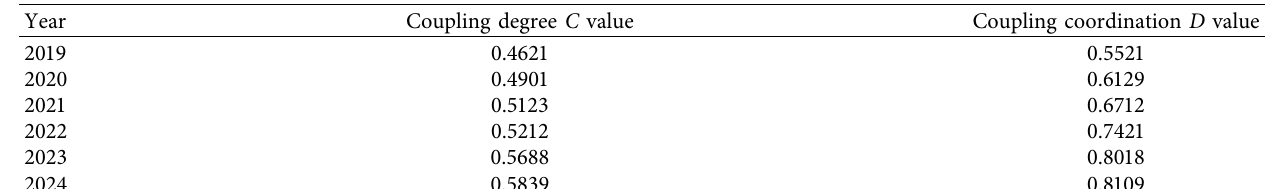
Table 6: Predicted values.